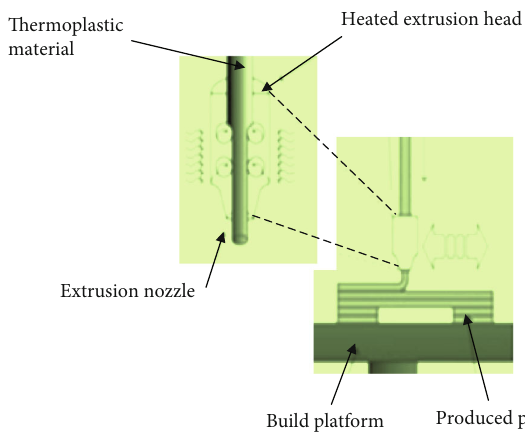
Figure 3: Schematic of the fused deposition method